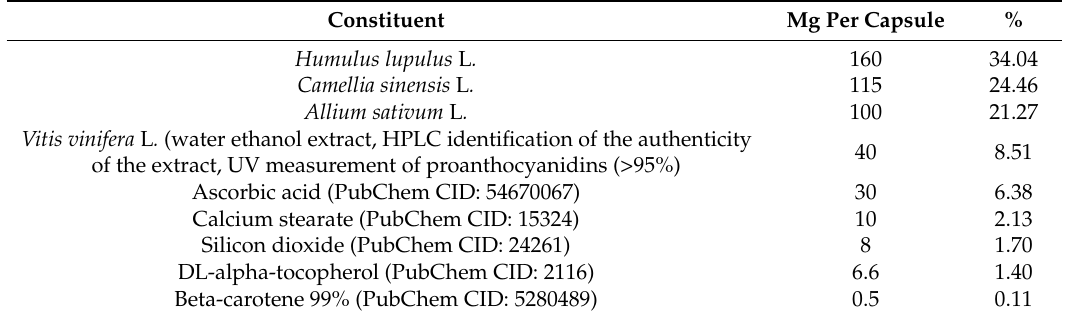
Table 4. Herbal and technological composition of isoflavonoid-rich herbal preparation “Karinat”.